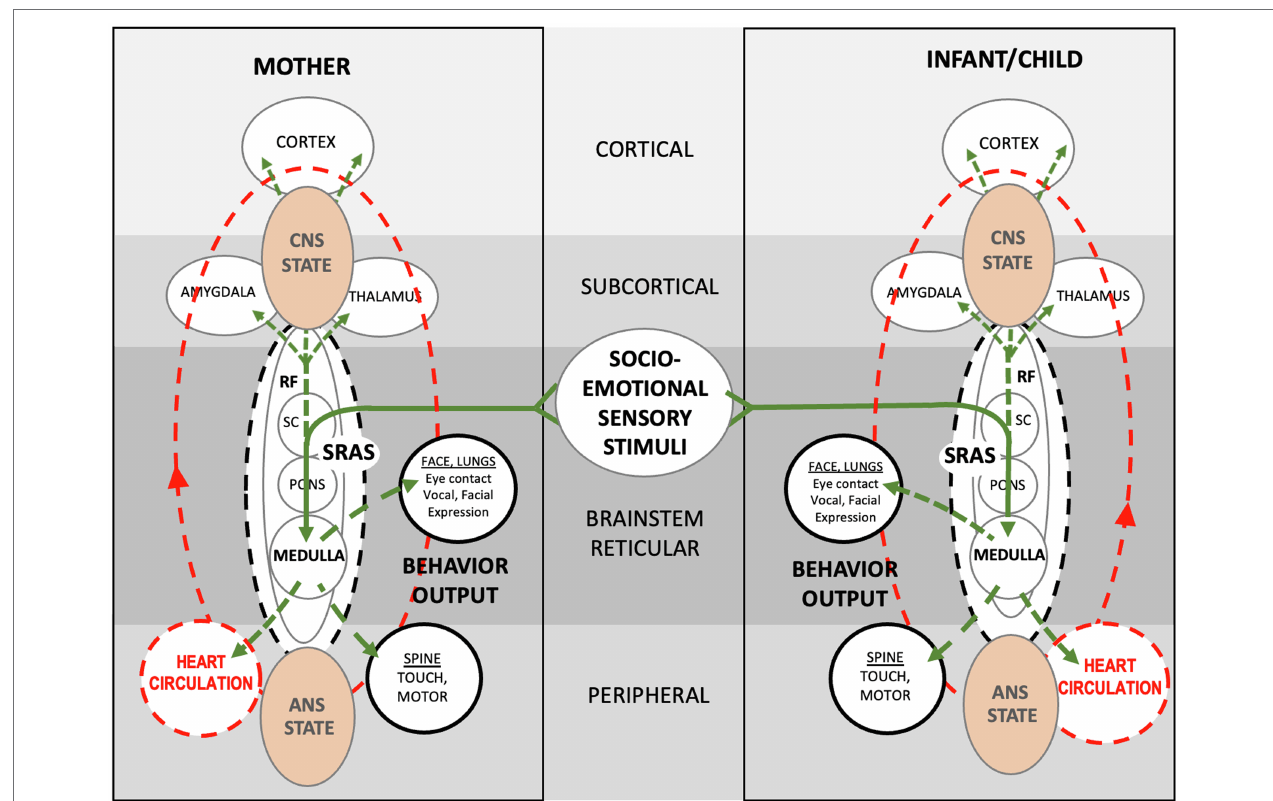
FIGURE 11 | Schematic showing theoretical autonomic socioemotional reflex (ASR) signaling arc . The arc begins when multimodal sensory stimuli from close mother and infant proximity and face-to-face communication ( Solid green lines ) activate neuronal signaling ( Dotted green lines ) and cardiovascular signaling ( Dotted red lines ). Sensory stimuli integrate within the reticular formation, where neurotransmitters spark electrochemical/hormonal signaling based on prior autonomic conditioning. The signaling ignites the systemic reticular activating system (SRAS), which transmits more or less instantaneously throughout the body and brain via neuronal and circulatory pathways and producing a body-wide autonomic state . Note that signal transmission occurs in two ways; via cardiovascular signaling (circulation) from the medulla to the heart, and via neuronal signaling from the medulla to the spine and brain. The autonomic states of mother and infant determine approach or avoidant behavior. The entire autonomic socioemotional reflex (ASR) signaling arc, from sensory stimuli to behavioral output ( listed in solid black circles ), takes less than a second to